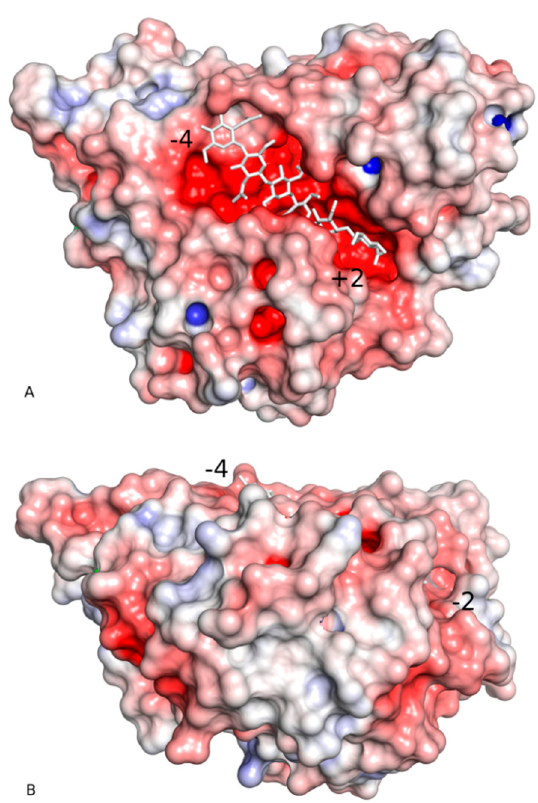
Figure 5. Two perpendicular views of the electrostatic surface representation of St Chi40 showing the substrate-binding groove ( A ) and the side view of the flat surface that contains the groove ( B ). Panel A shows the molecule in the same orientation as in Figures 2 and 4. The electronegative (red) character of the binding site is clearly visible. The insertion domain is at the top-right side of panel A. The substrate (white sticks) is modelled by superposing chitinase A from Vibrio harveyi complexed with NAG 6 (PDB code 3b9a) onto St Chi40 [17]. Terminal substrate-binding subsites are labelled.